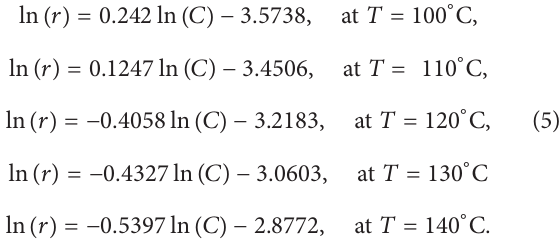
Table 1: The rate of reaction (g/min) of PVC resin at different times (min) and at different temperatures (100–140 ∘ C). Time (min) At curing 𝑇 = 100 ∘ C